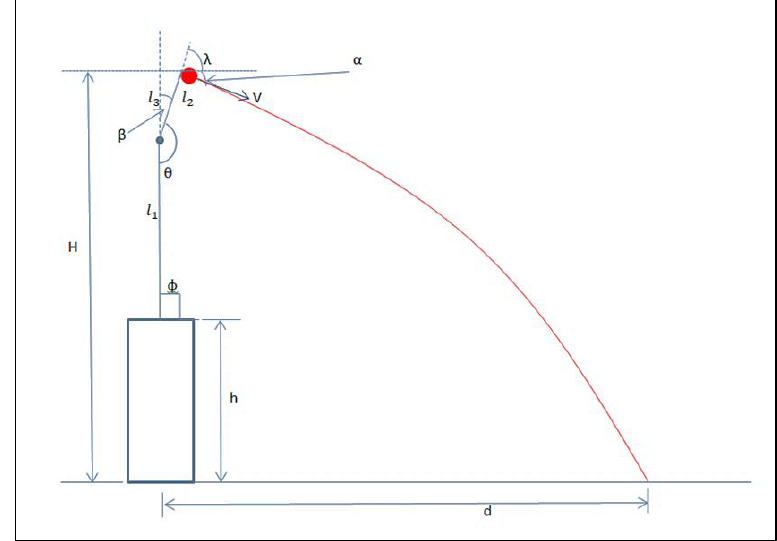
Figure 5. The projected path with the wrist β to the vertical [32]